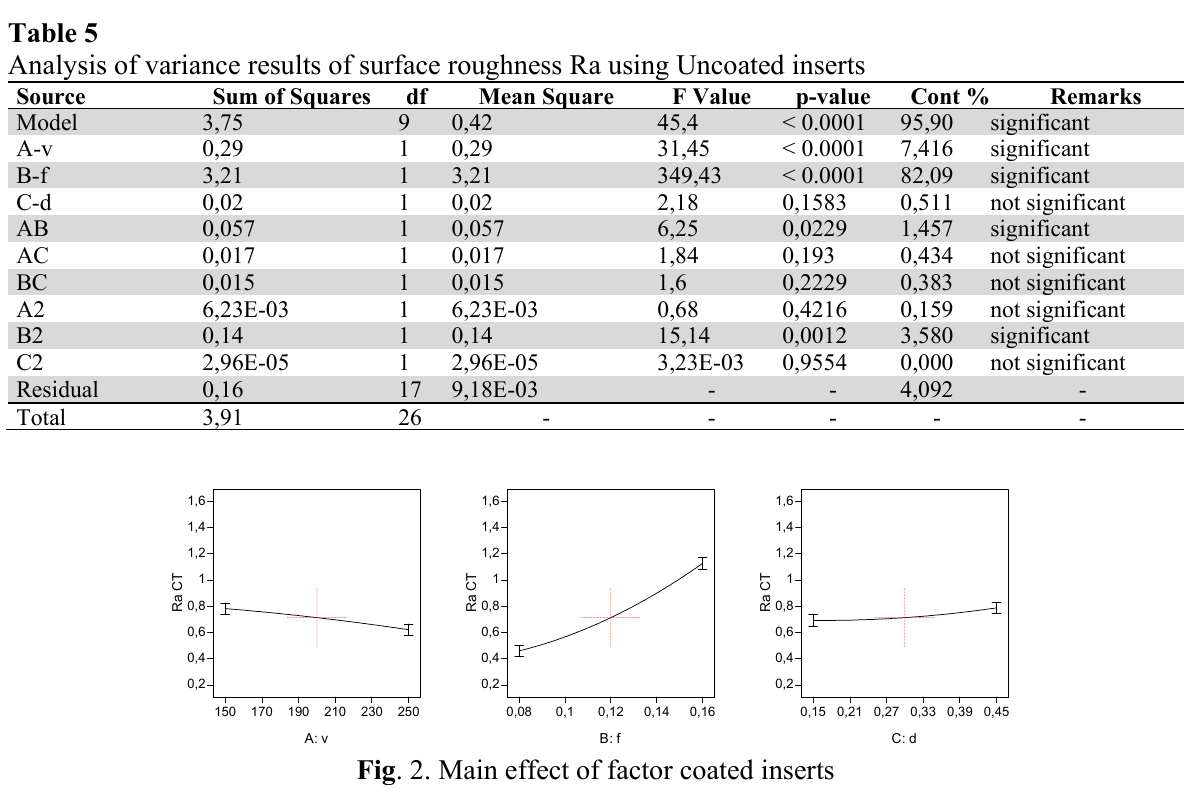
Fig . 2. Main effect of factor coated